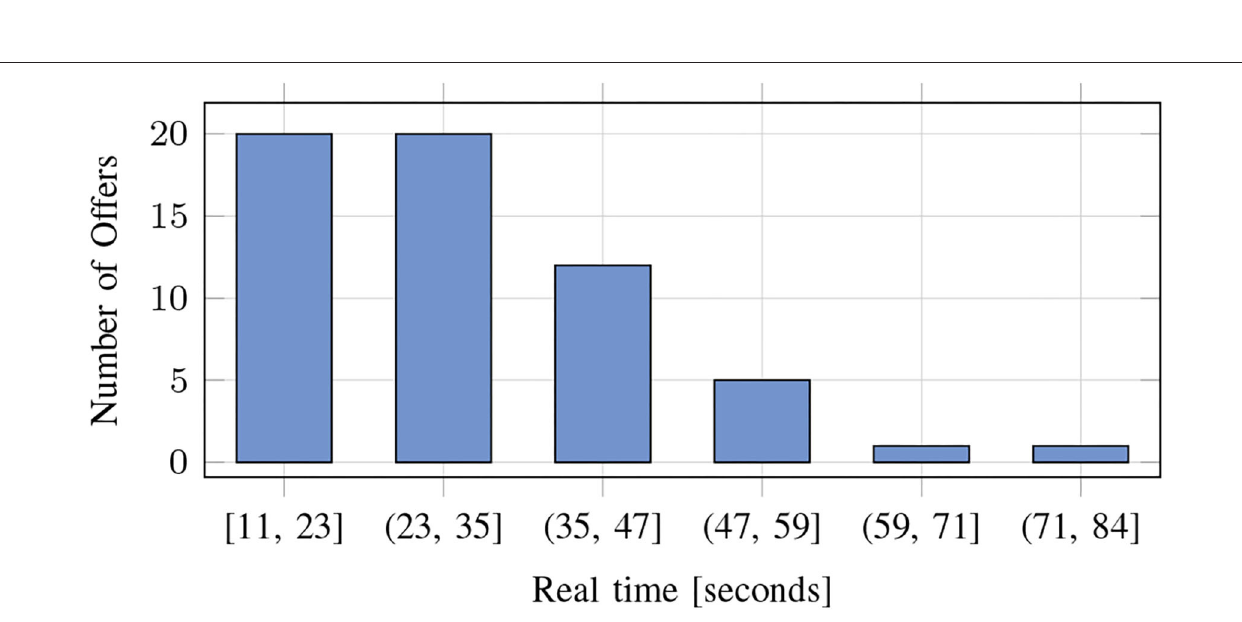
Frontiers in Blockchain |